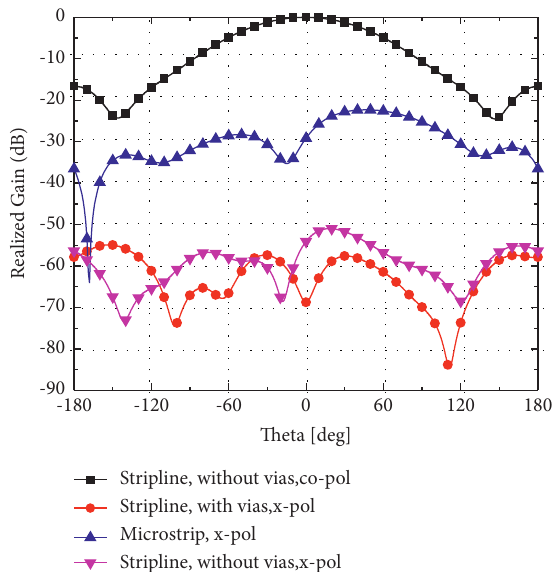
Figure 6: Comparison of the pattern ( H -plane) and cross-polarization of different structures.